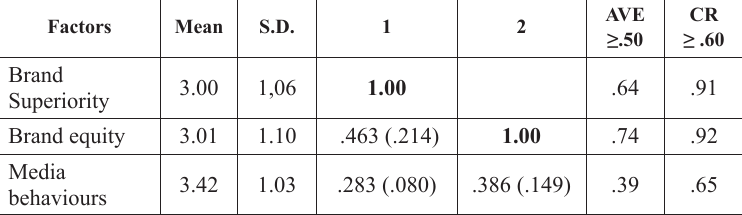
Figure 1. Proposed structural